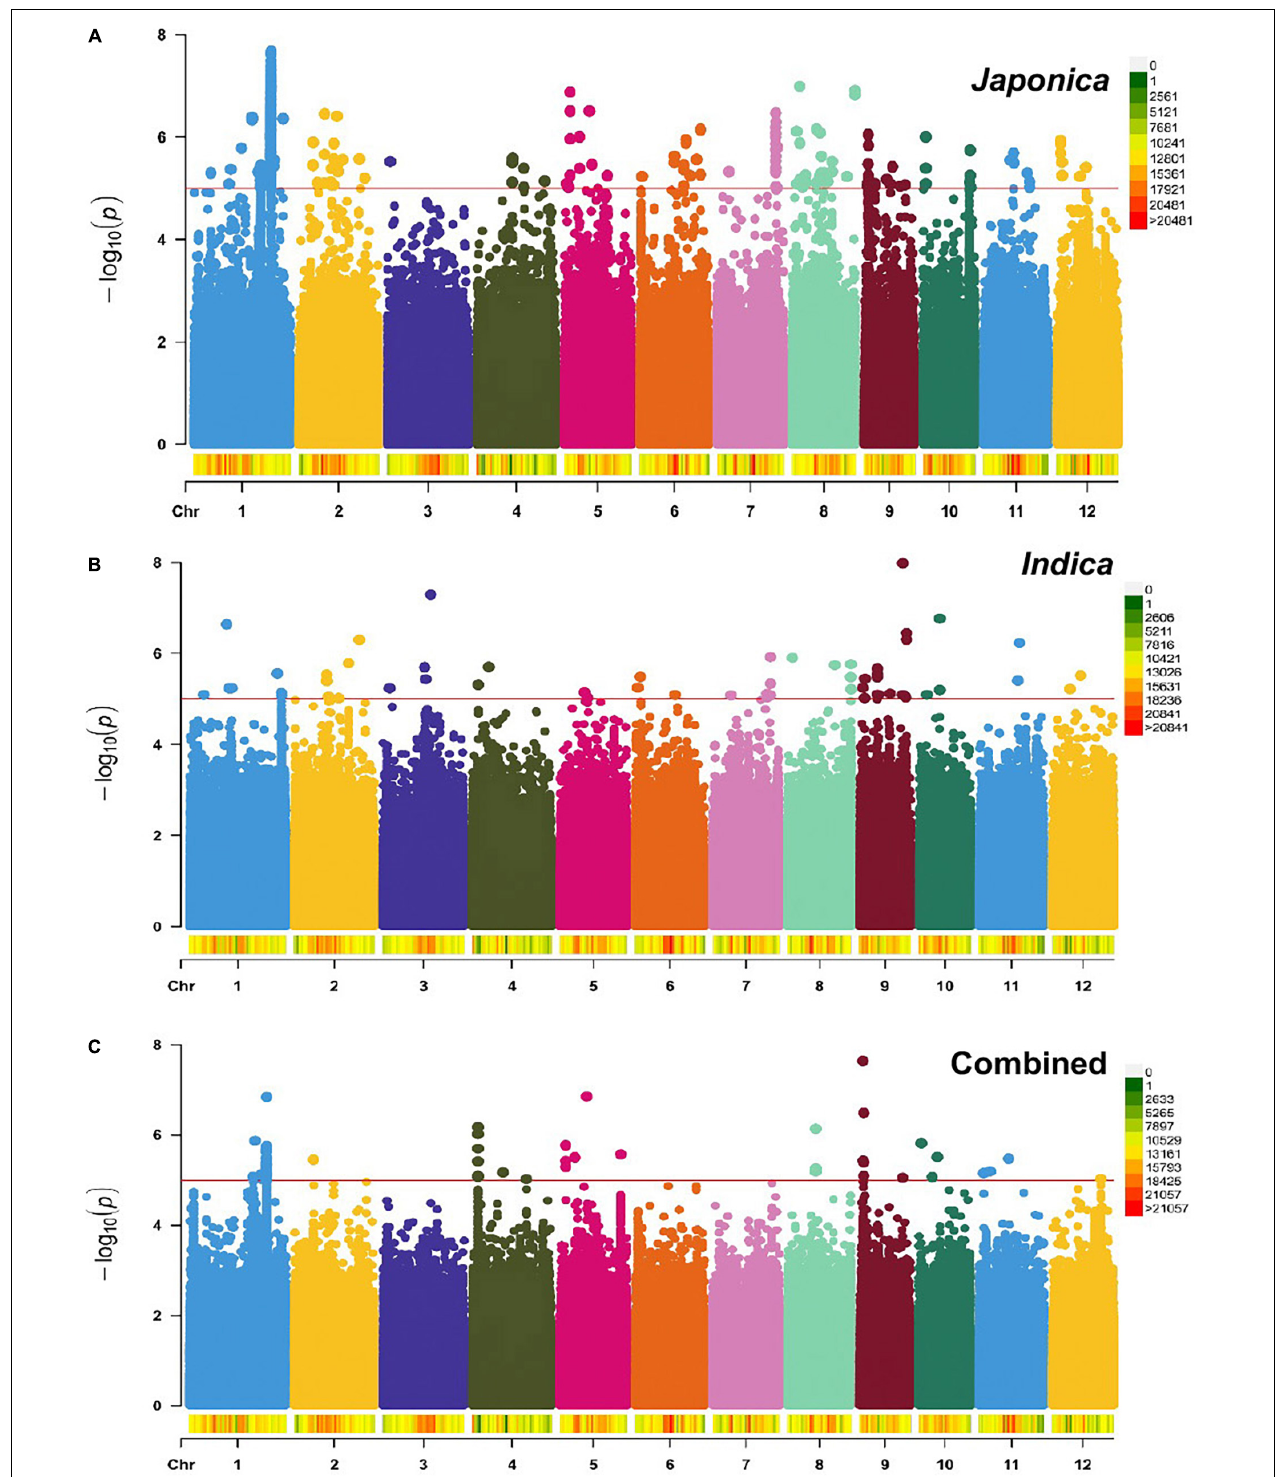
FIGURE 5 | Manhattan plots showing genome-wide single nucleotide polymorphisms (SNPs) associated with PL (cm) in the Japonica (A) , Indica (B) , and Combined (C) populations, respectively, under HNT stress across the rice genomes. The red line represents the association threshold –log 10 p ≥ 1e–05. The right-hand side scale of each plot indicates the distribution of genome-wide SNPs across the rice genomes that were used in this study.